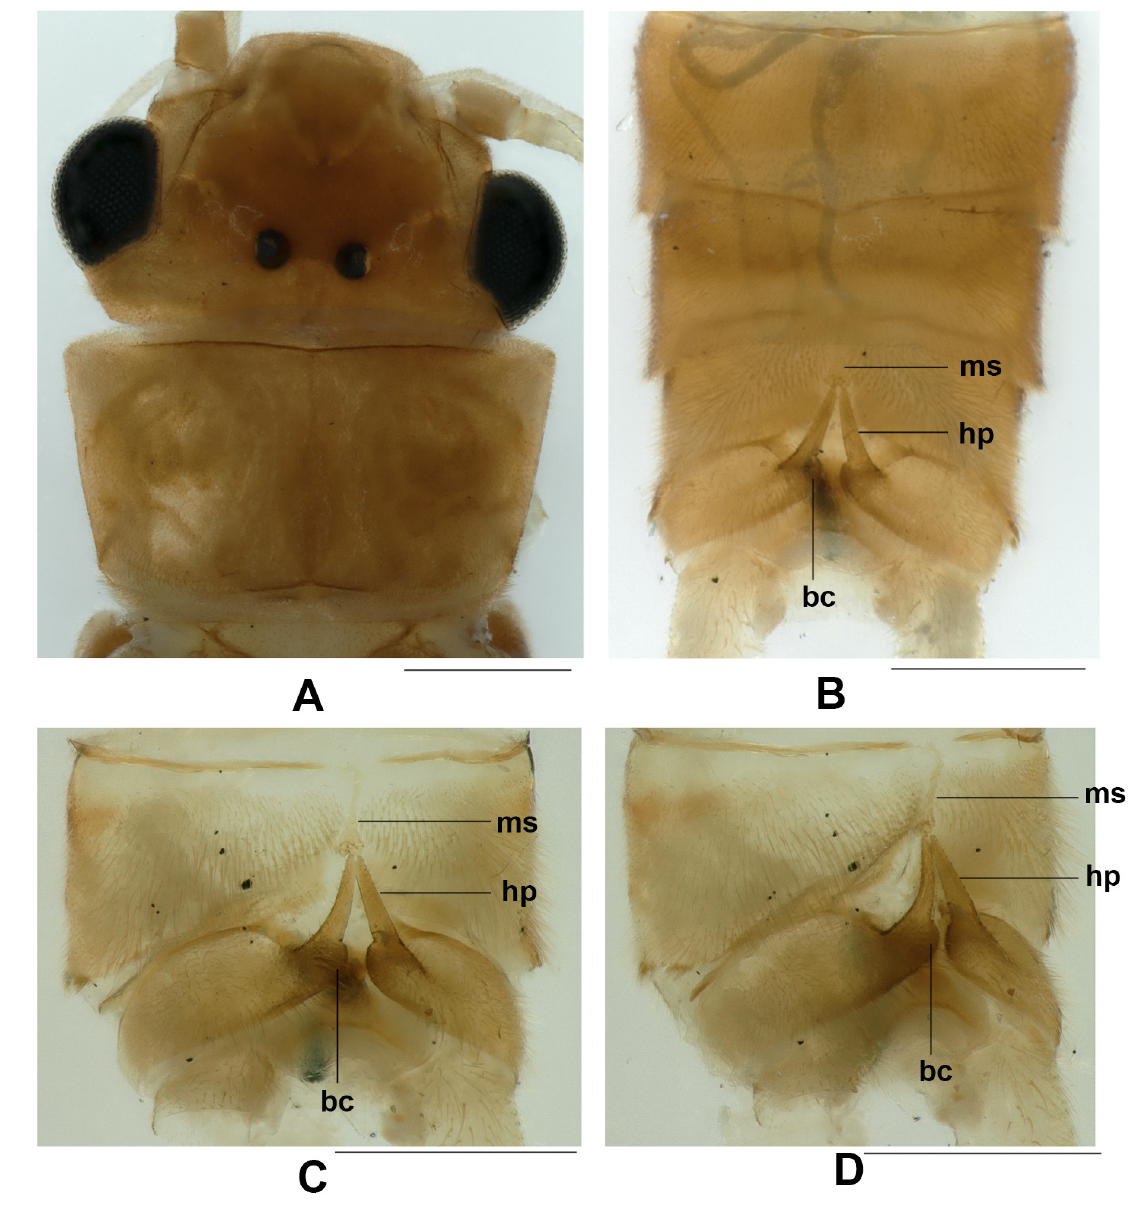
Fig. 11. Chinoperla gorohovi Sivec & Stark, 2010, ♂ (CAU). A . Head and pronotum, dorsal view. B . Terminalia, dorsal view. C . Cleared terminalia, dorsal view. D . Cleared terminalia, oblique lateral view. Abbreviations: see Material and methods. Scale bars = 0.5